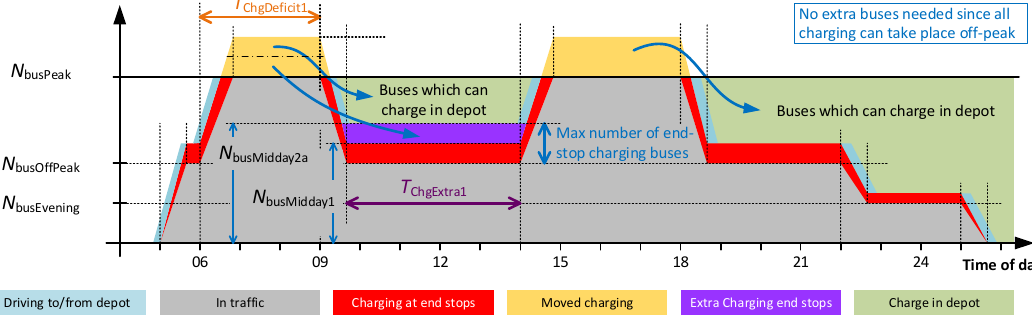
Figure 8. How the number of buses during peak traffic can be reduced by moving charging to other times.